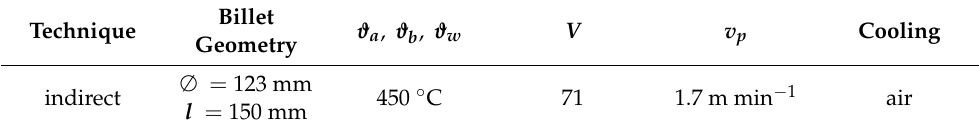
Table 2. Parameters of the hot extrusion process. Technique